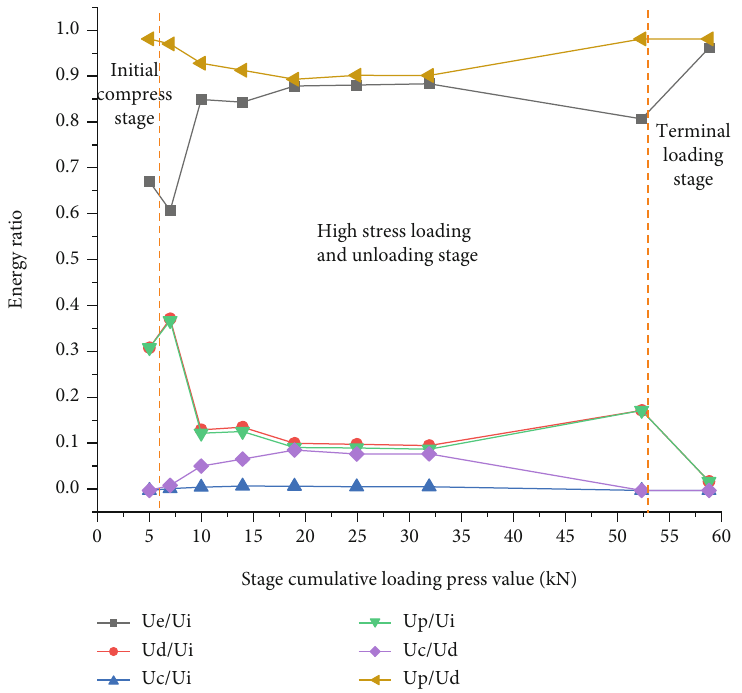
Figure 14: Relationship between energy proportion and stage cumulative loading press value with sample B1.